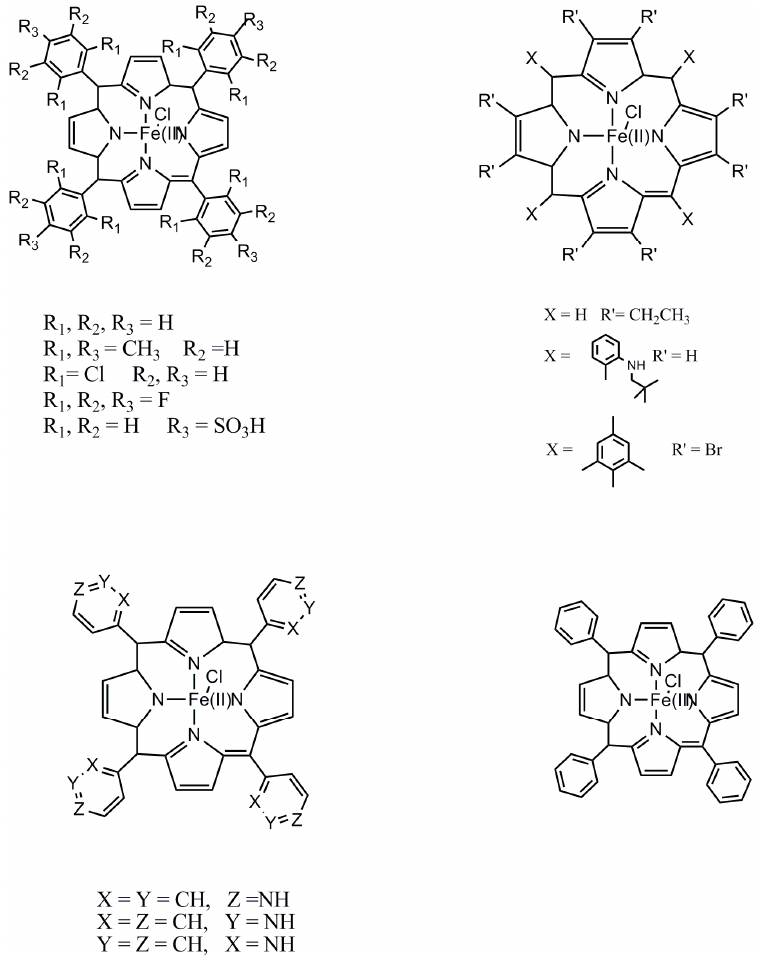
Figure 22. Some examples of Fe(III) porphyrins with different peripheral substituents which act as molecular photocatalysts in the process of photoactivated CO 2 reduction ([169,183] and references therein).